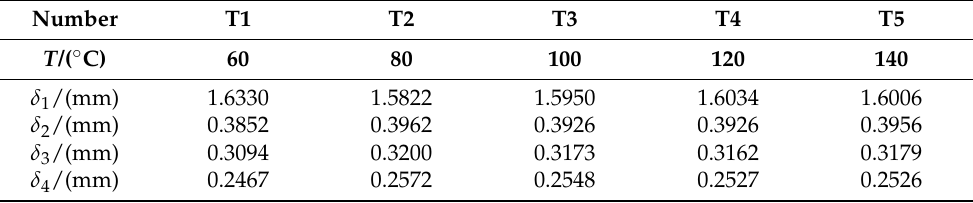
Figure 5. Variations of gaps and the NUC in the disengaging process with different ATF temperatures. Table 2. Simulation results with different ATF